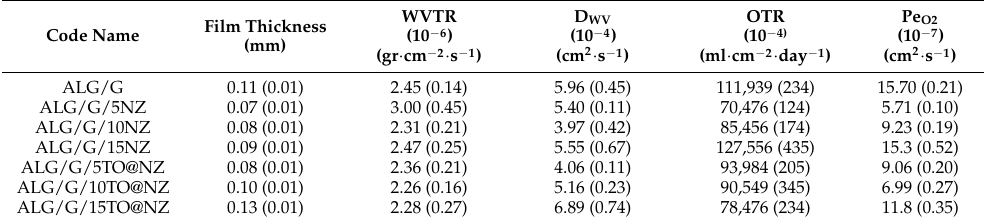
Table 2. Measured values of water-vapor transmission rate WVTR and oxygen transmission rate OTR. Calculated values of water diffusion coefficient D WV and oxygen permeability coefficient Pe O2 for all obtained